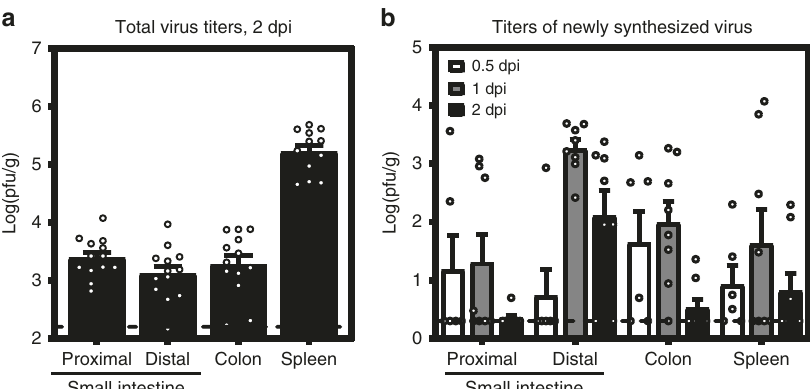
Fig. 4 MNV-1 establishes productive infection in neonatal mice. a Three-day-old BALB/c pups ( n = 13) were infected with 10 8 TCID 50 units of MNV-1. At 2 dpi, viral titers were determined in the indicated segments of the intestinal tract and spleen by plaque assay. b Three-day-old BALB/c pups were infected with 2.5 × 10 4 pfu of neutral red-labeled MNV-1 by oral gavage At 0.5 dpi ( n = 5, white), 1 dpi ( n = 8, gray), and 2 dpi ( n = 8, black), plaque assays were used to measure newly synthesized virus. Error bars denote standard errors of mean in all fi gures. Source data are provided as a Source data fi